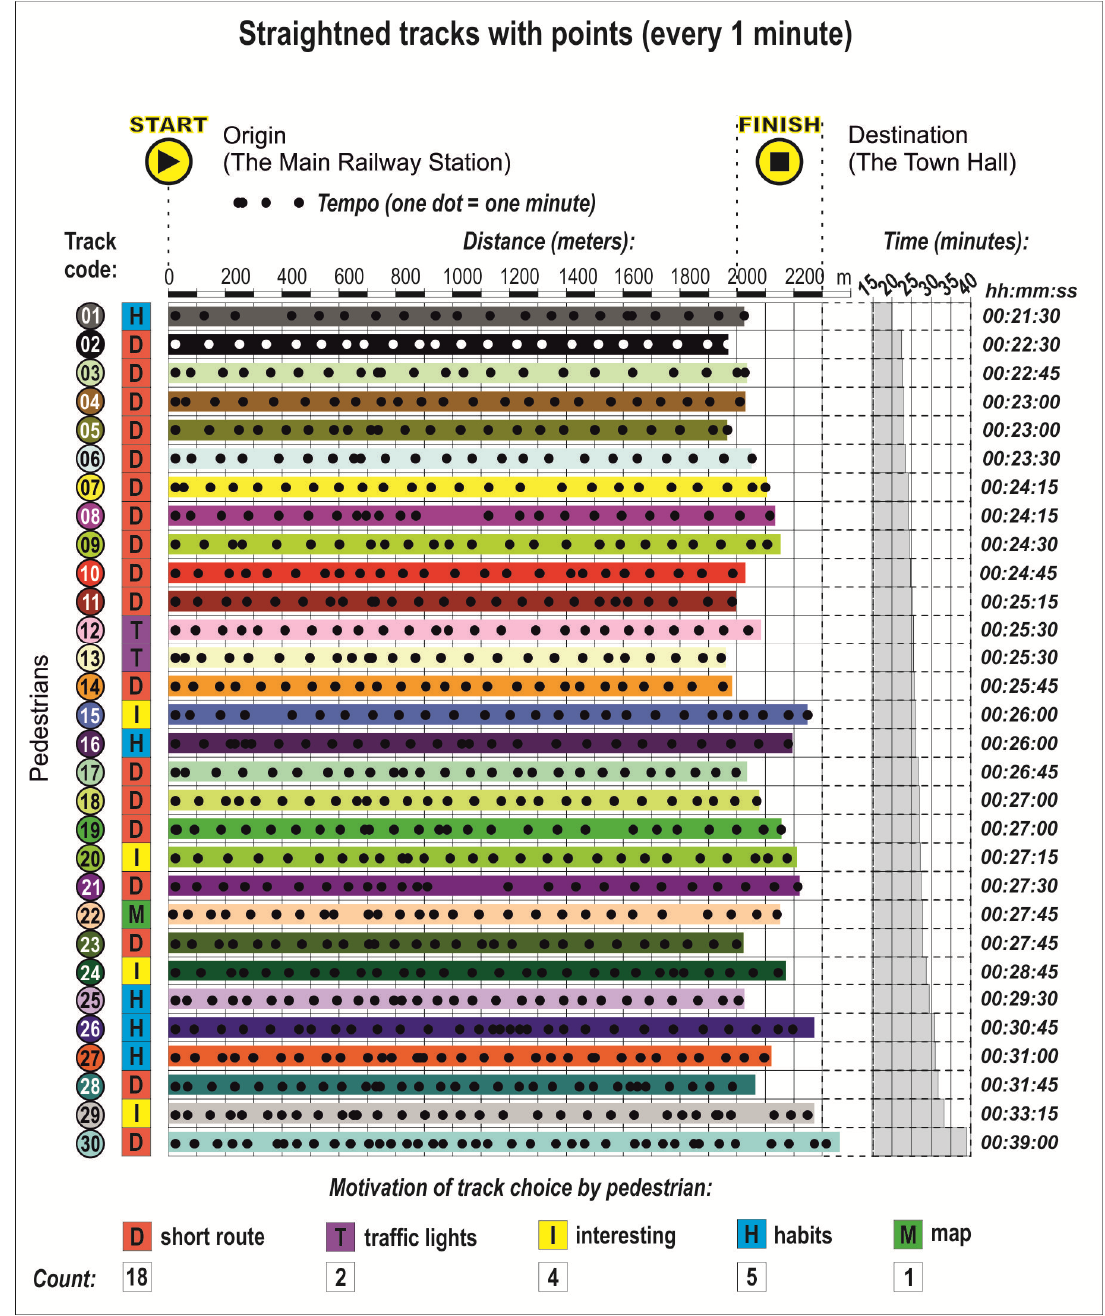
Figure 5. Horizontal graph in a linear composition with 30 classified routes.